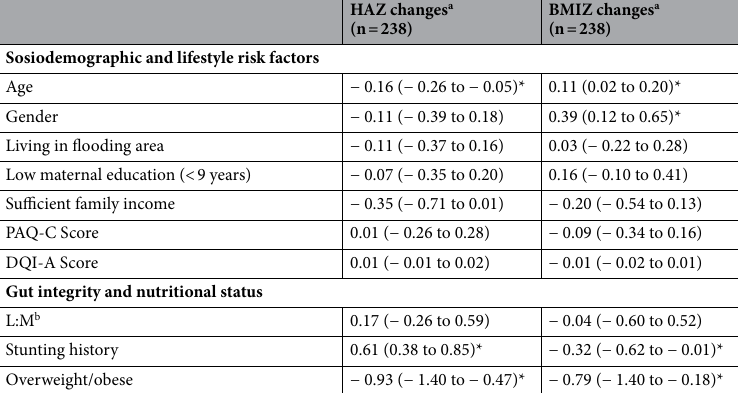
BMIZ changes a (n = 238)